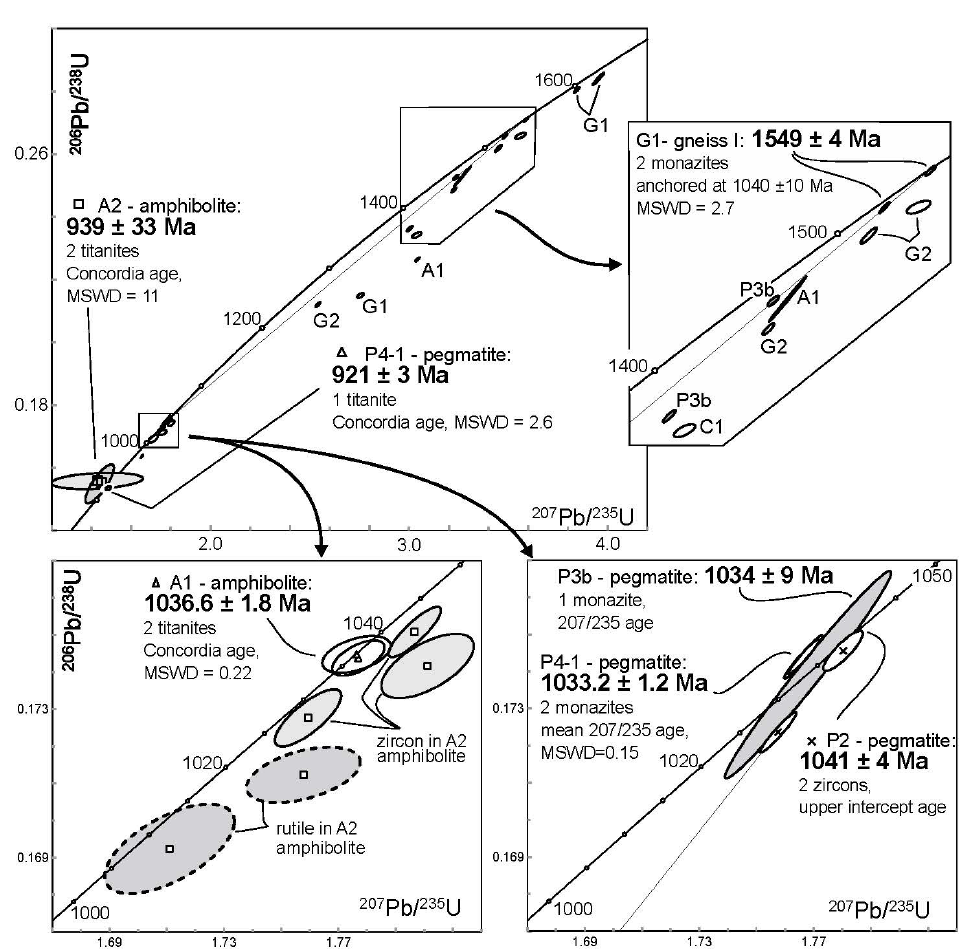
Figure 8. Concordia plots with the U–Pb data for biotite gneiss samples G1 and G2, cataclasite C, amphibolites A1 and A2, and pegmatites of Type 2 (P2), Type 3b (P3b) and type 4 (P4-1). Sample P4-2 gave discordant data that plot outside the diagrams. Ellipses indicate 2 sigma uncertainties. Data in Table